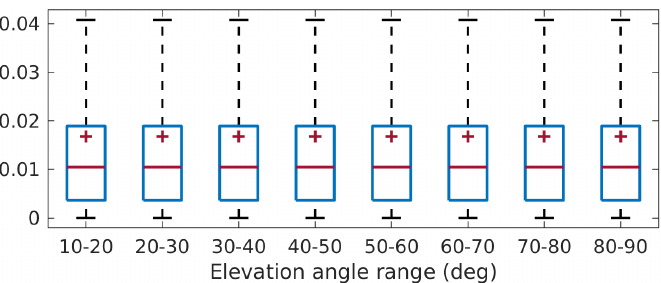
Figure 18. Boxplots of the absolute error by elevation angle range. Simulation results vs pro- posed